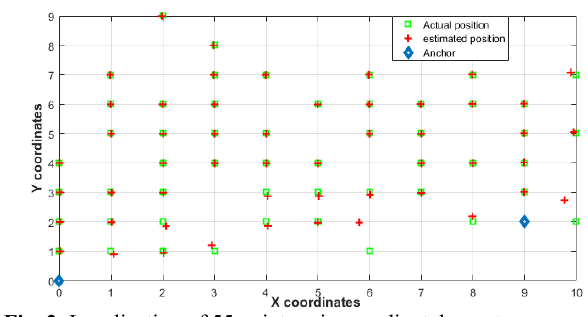
Fig. 4. Localization of 20 points using initialization